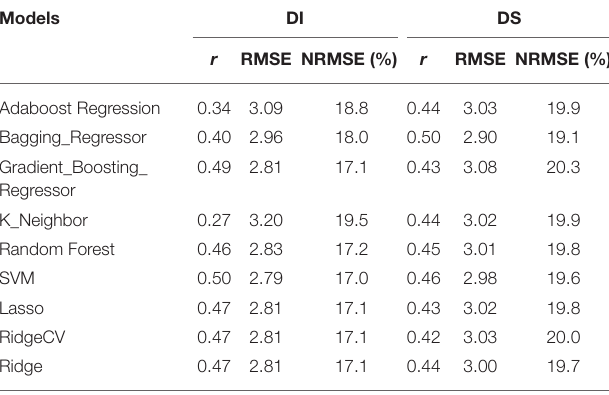
TABLE 5 | Model analysis of CC for predicting vegetation index during flowering.